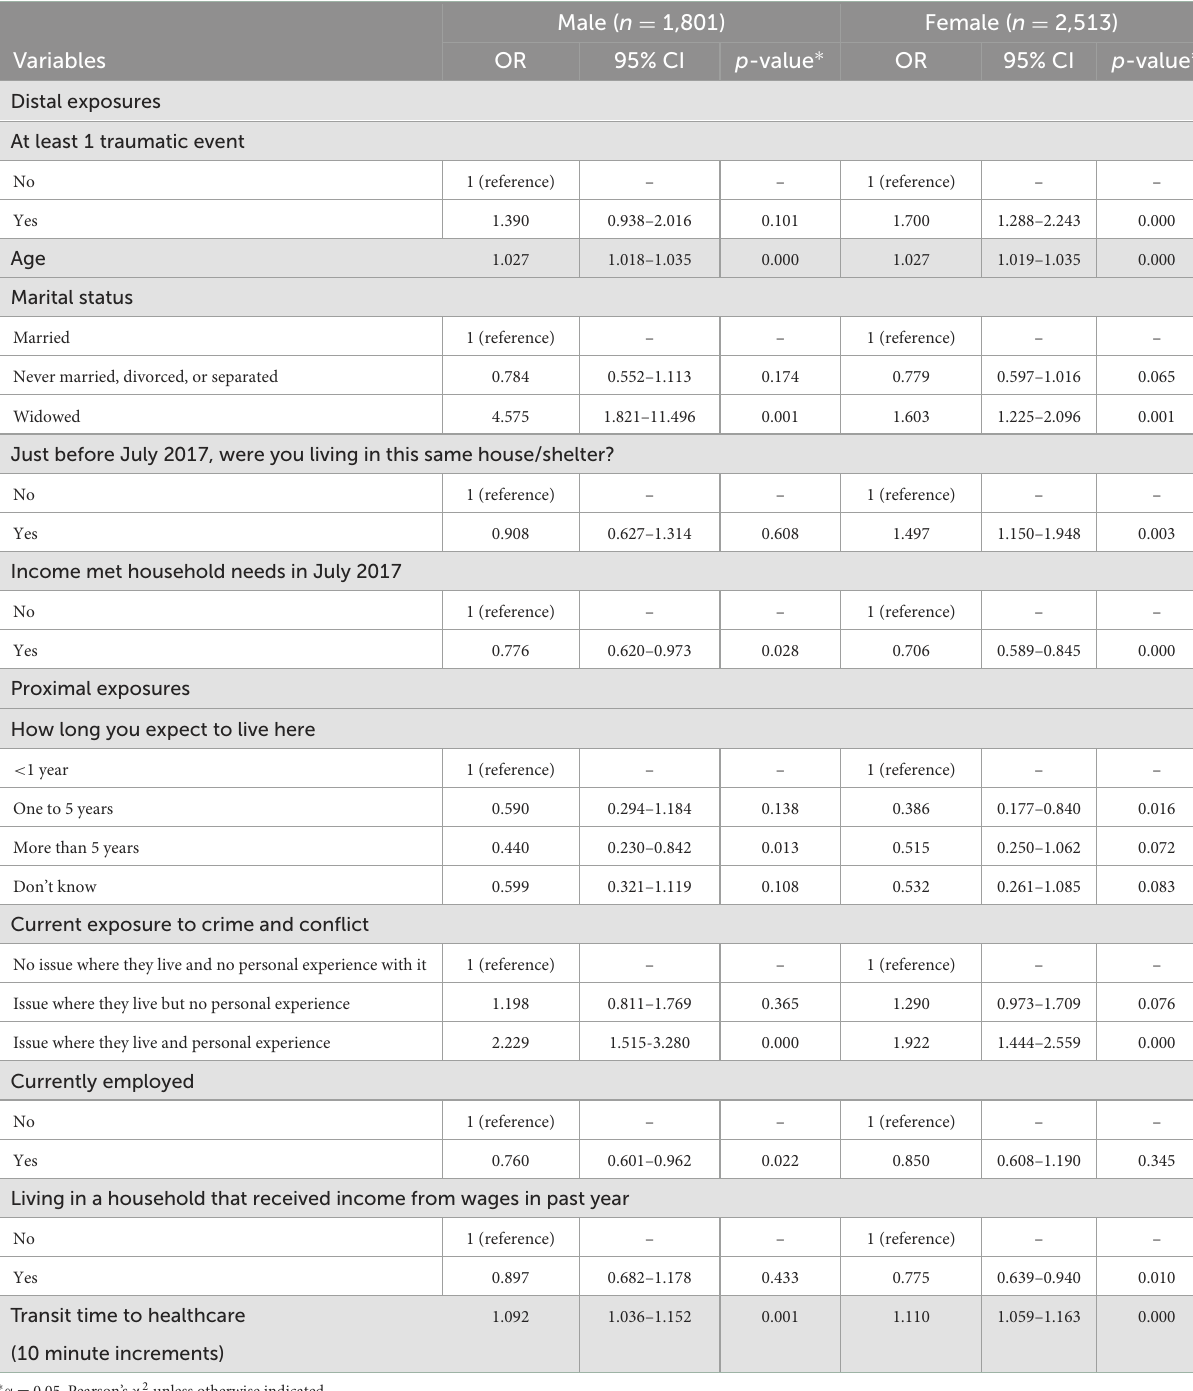
TABLE 3 Multivariable logistic regression model for depression among Rohingya refugees living in Cox’s Bazar, Bangladesh, stratified by gender ( n =